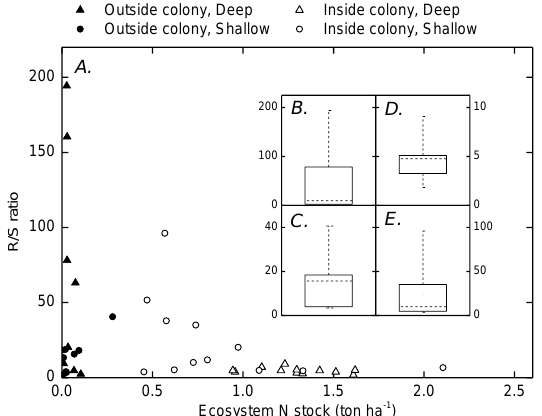
Figure 7. Relationship between R/S ratio (Root/Shoot ratio) and N stock (a) . Central figure shows box plots of the R/S ratio on Fig. 7. Relationship between R/S ratio (Root/Shoot ratio) and N stock (A). Central figure shows 735 deep tephra sand outside the colony (b) , shallow tephra sand outside boxplots of the R/S ratio on deep tephra sand outside the colony (B), shallow tephra sand outside 736 the colony (c) , deep tephra sand inside the colony (d) and shallow the colony (C), deep tephra sand inside the colony (D) and shallow tephra sand inside the colony 737 tephra sand inside the colony (c) . Boxes show 25, 50 and 75 per- centile, whiskers show 5 and 95 percentile. Note the differences in (C). Boxes show 25, 50 and 75 percentile, whiskers show 5 and 95 percentile. Note the 738 scale of the y axes. Samples lacking roots or shoots were excluded differences in scale of the y-axes. Samples lacking roots or shoots were excluded from the 739 from the graphs. 740